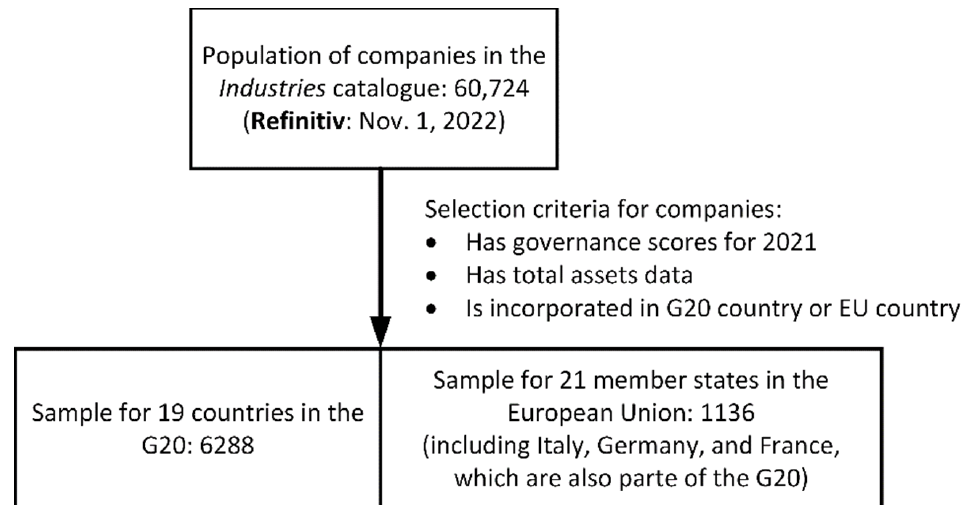
Figure 1. A summary of sample selection.